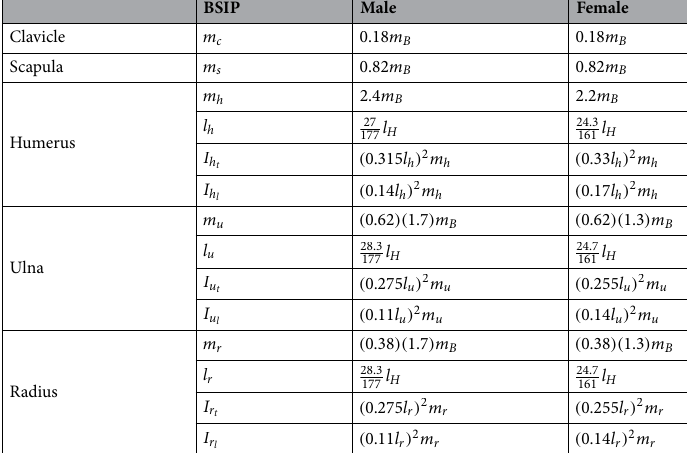
, I u , I r , I h , I u , and I r , respectively. The t t t l l l